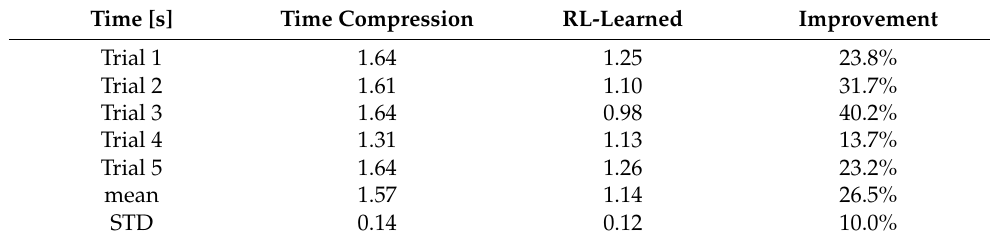
Table 6. The results of speed optimization.